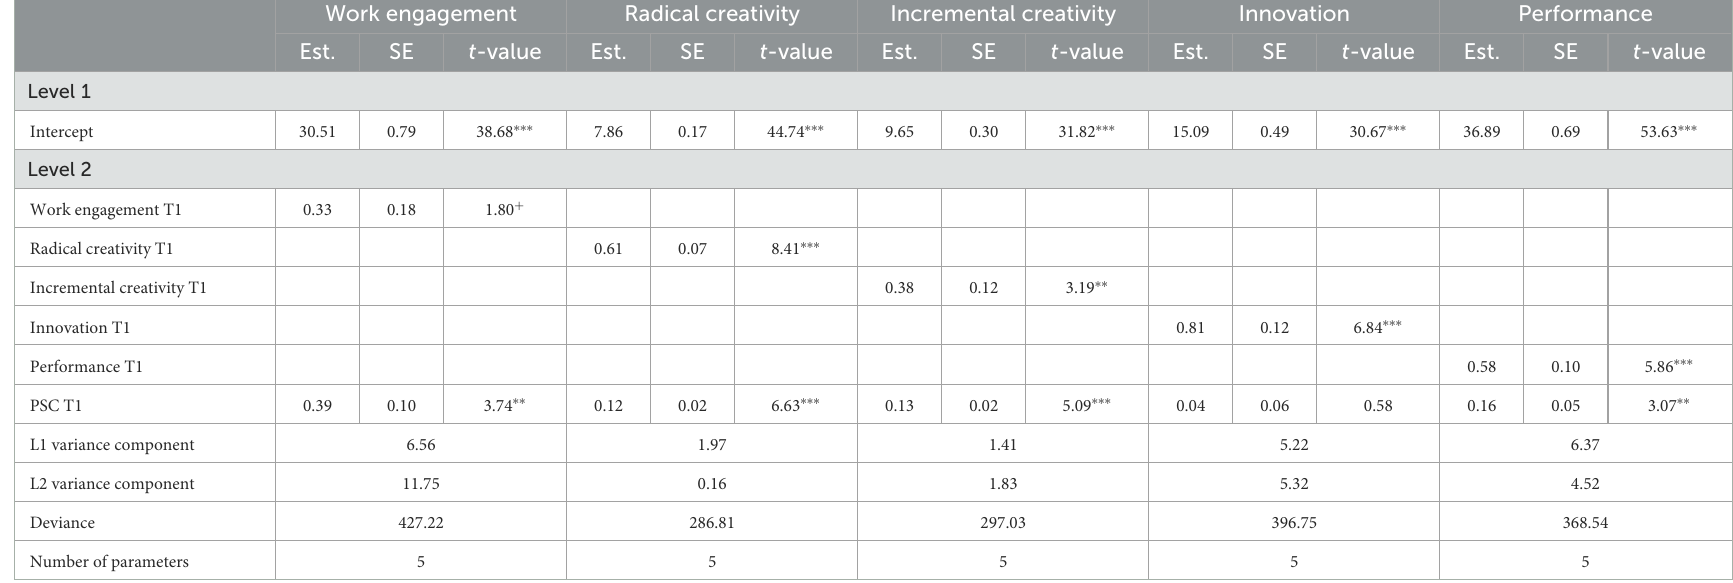
TABLE 2 HLM results of the effect of PSC on all the other variables, controlling baseline value. Work